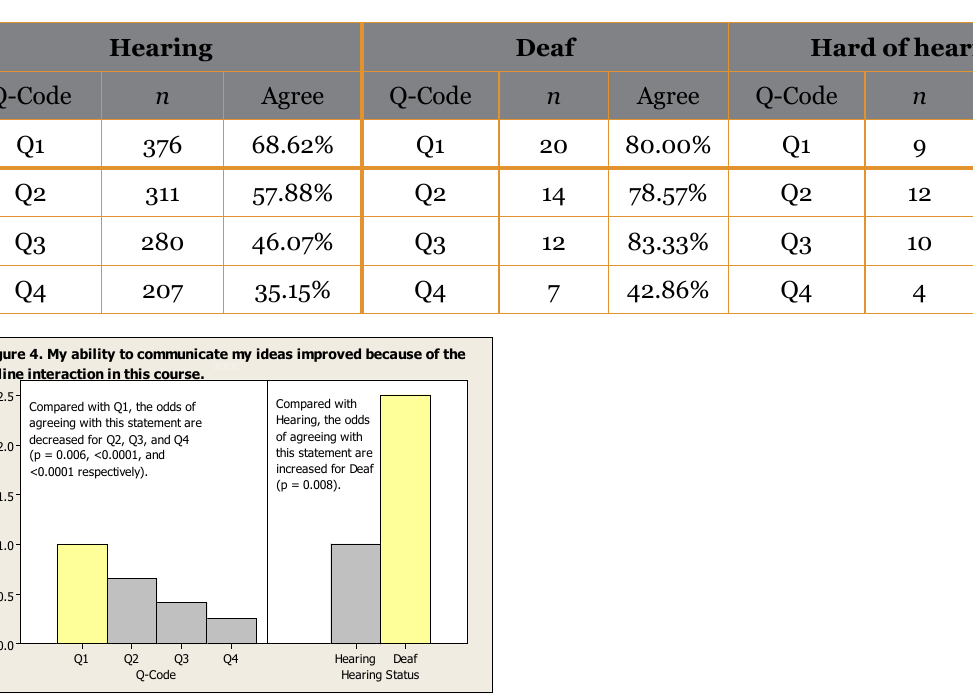
Figure 4 . Odds-Ratios for “My ability to communicate my ideas improved because of the online interaction in this